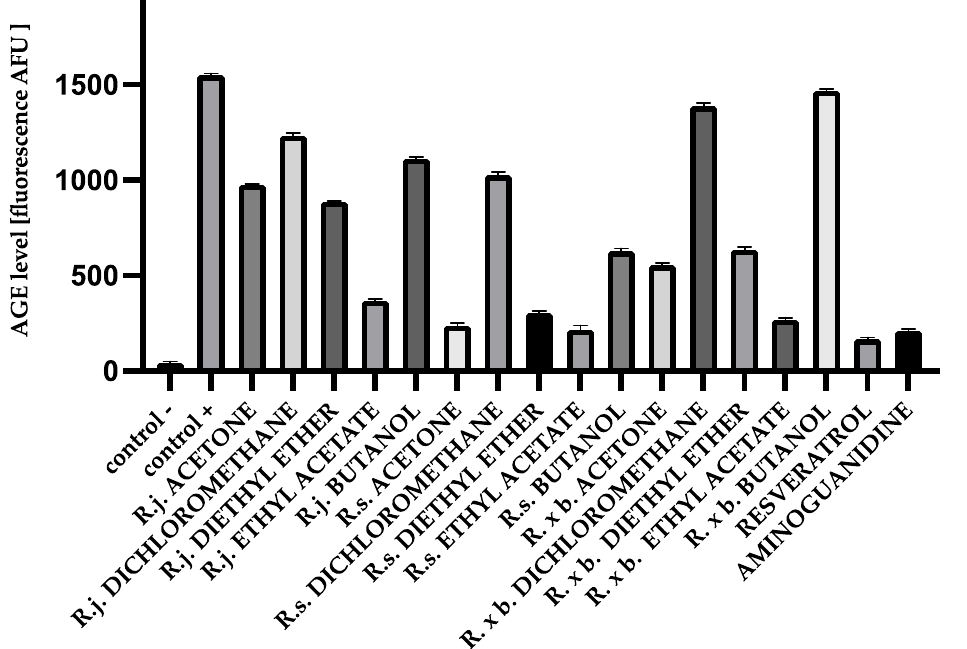
Figure 4. The effect of extracts and fractions on the formation of fluorescent AGEs in the in vitro BSA glycation. R.j., R.s., and R. × b. mean Reynoutria japonica , Reynoutria sachalinensis , and Reynoutria × bohemica , respectively. Error bars shown in this figure are means ± SD for n ≥ 5. All results were statistically significant at p ≤ 0.0001 compared to control +. Detailed information can be found in the Supplementary